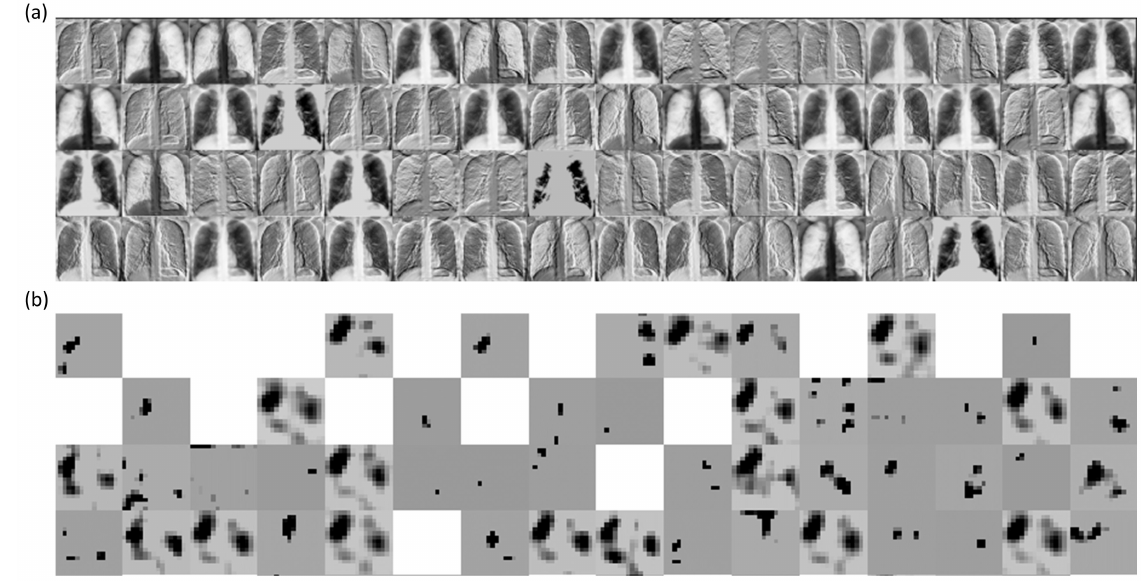
Figure 12. Visualizing the activations of the first 64 filters using the best-performing bone-suppressed model with a sample CXR from the Shenzhen TB collection. ( a ) block1-Conv1 layer and ( b ) block5-conv3 layer.